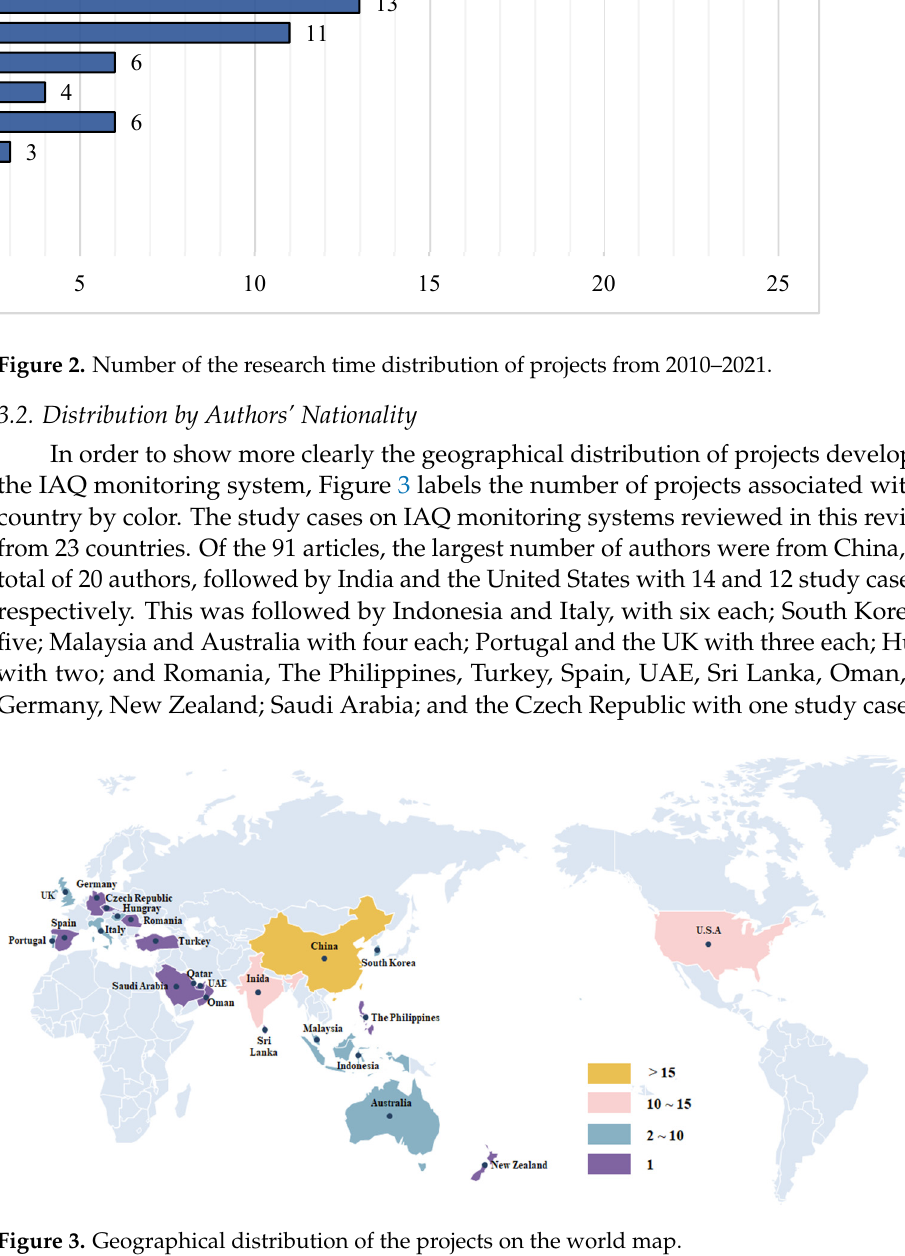
Figure 3. Geographical distribution of the projects on the world map.